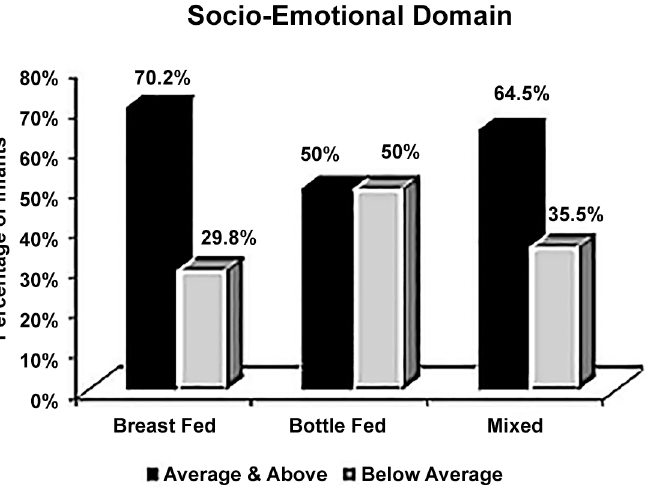
Fig 1. Percentage distribution of infants in each feeding group according to the reference average socio-emotional composite score in a group of 655 Egyptian infants and children aged 6 – 24 months